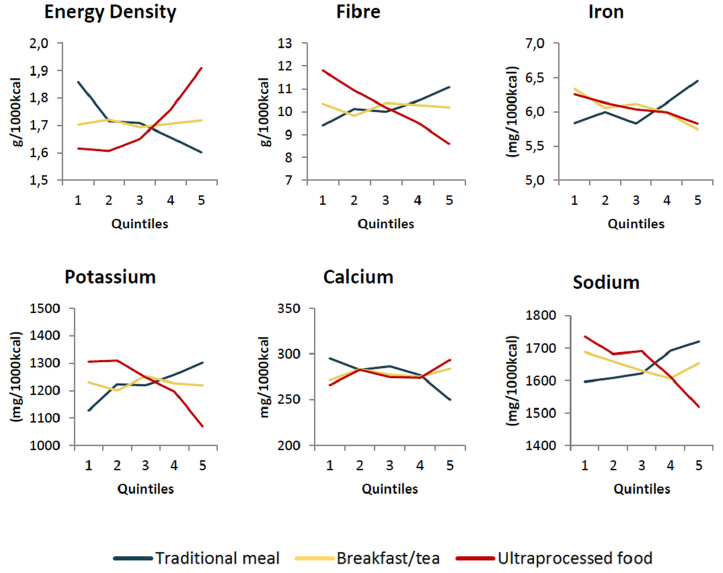
Figure 2. Predicted amount of energy density, fiber, iron, potassium, calcium and sodium content according to fifths participation in eating out pattern scores, adjusted for personal, sociodemographic and socioeconomic characteristics and the percentage of calories consumed out. Brazilian population 10 years old and over (2008–2009).